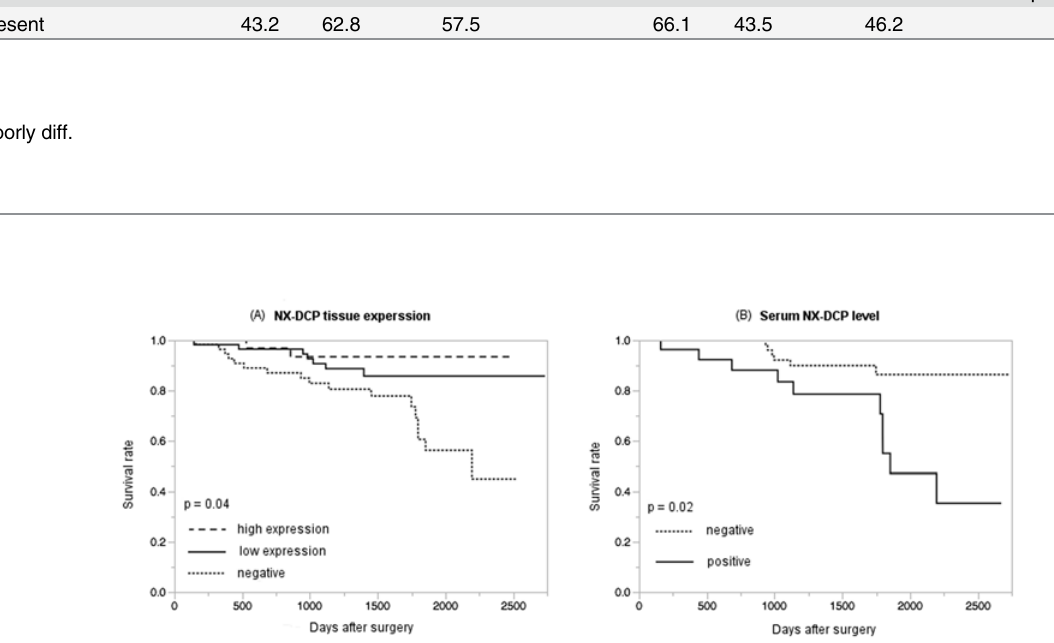
Fig 3. Survival rate of HCC patients according to NX-DCP expression level in HCC tissue or serum NX-DCP level. (A) The cases with negative NX-DCP expression (dotted line) showed lower survival rate (p = 0.04). Dashed line, high NX-DCP expression; solid line, low NX-DCP expression; dotted line, negative cases. (B) The survival rate of the serum NX-DCP positive cases (solid line) was significantly lower than that of negative cases. Dotted line, serum NX-DCP negative; solid line, positive cases.